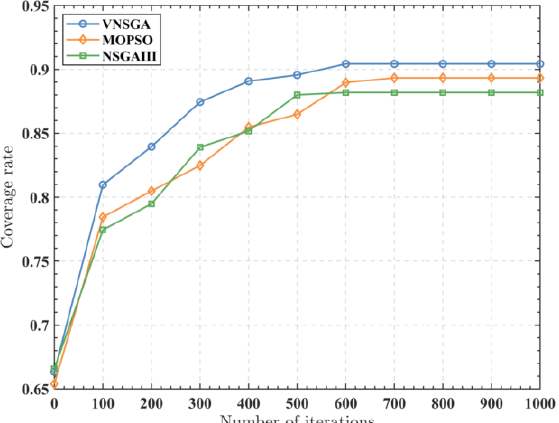
Figure 15. Unbalanced energy consumption for three algorithms from different iterations for 100 m R smax and 200 m R cmax with respect to area A.